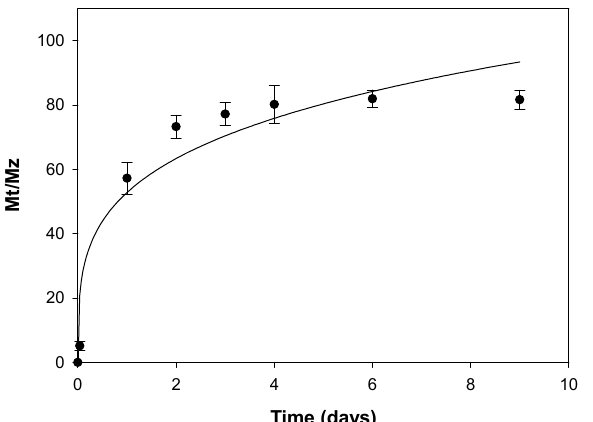
Figure 2. Release of S-carvone into water from the prepared granules. Symbols are experimental data points whereas the line is the fit to the equation Mt/Mz = kt n + c.